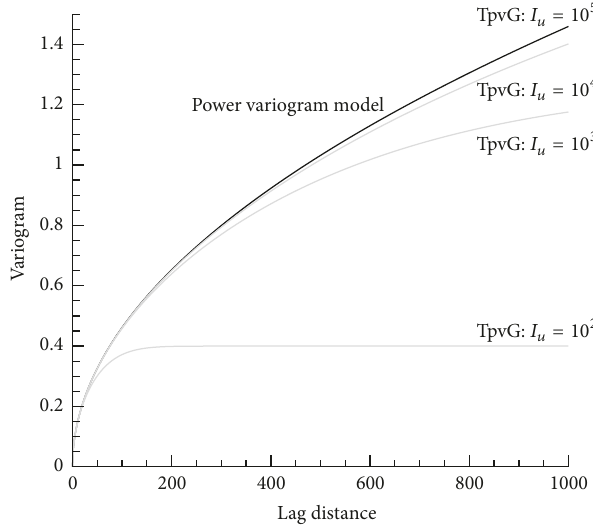
Figure 1: The equivalency of TpvG and power variogram